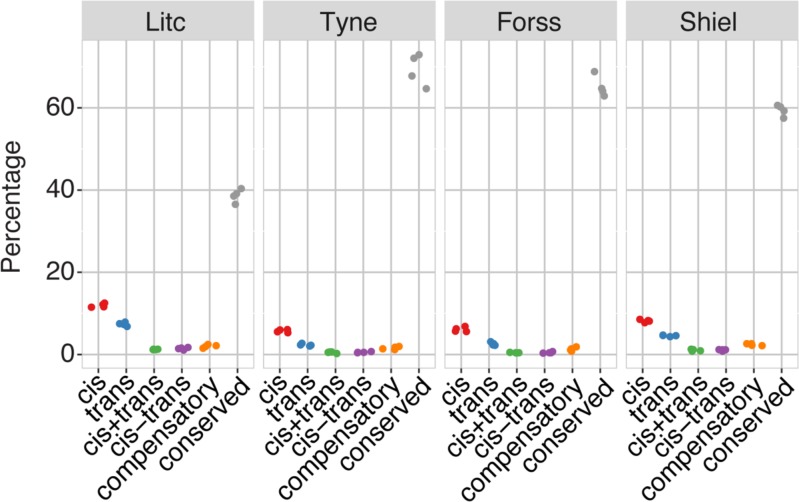
Frequencies of genetic architectures of expression divergence in down-sampled (30M uniquely mapping reads per sample) dataset.